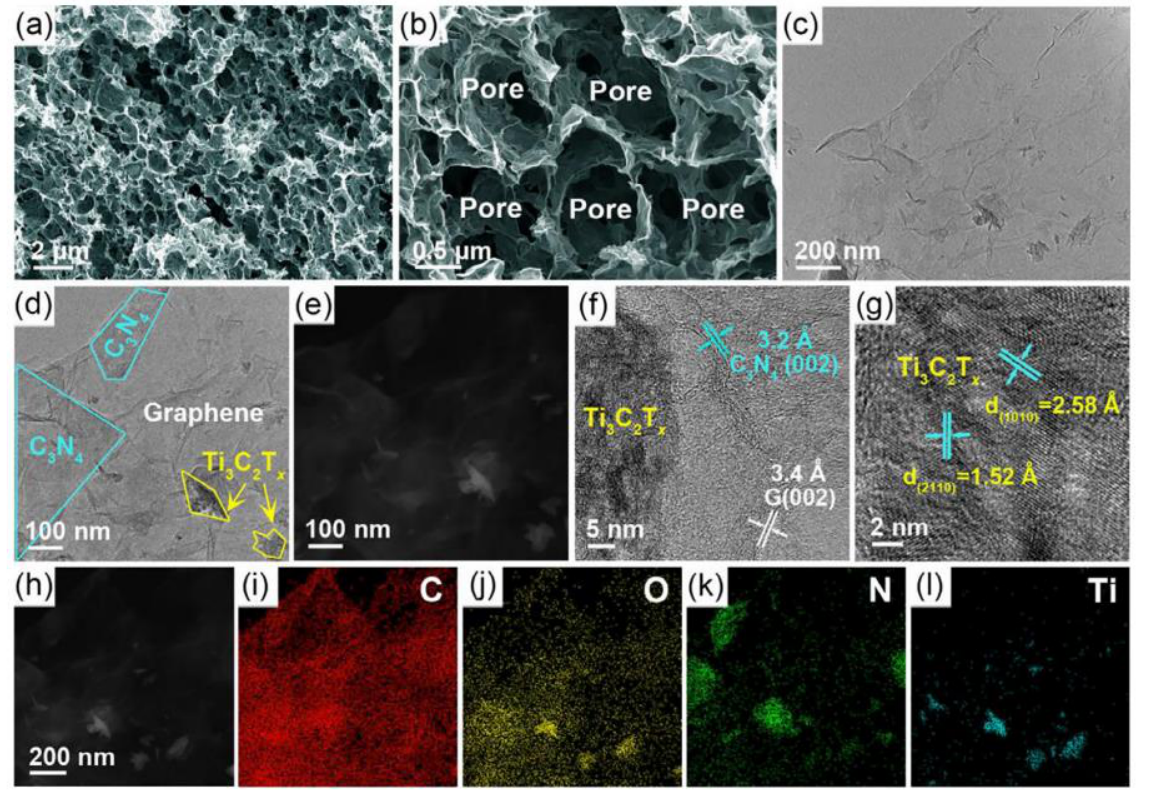
Figure 8. Morphological and microstructural analysis of the 3D MX/CN/RGO nanoarchitecture. Representative ( a , b ) FESEM, ( c , d ), TEM and ( e ) HAADF-STEM images reveal the successful integration of Ti 3 C 2 T x , g-C 3 N 4 nanosheets and graphene into a 3D interconnected framework. ( f , g ) HR-TEM images disclose the lattice fringes of Ti 3 C 2 T x and g-C 3 N 4 nanosheets. ( h ) HAADF-STEM image and corresponding elemental mapping analysis demonstrate that the 3D hybrid nanoarchitecture is composed of ( i ) C, ( j ) O, ( k ) N and ( l ) Ti elements. Adapted with permission from [158], Copyright 2022, Elsevier.